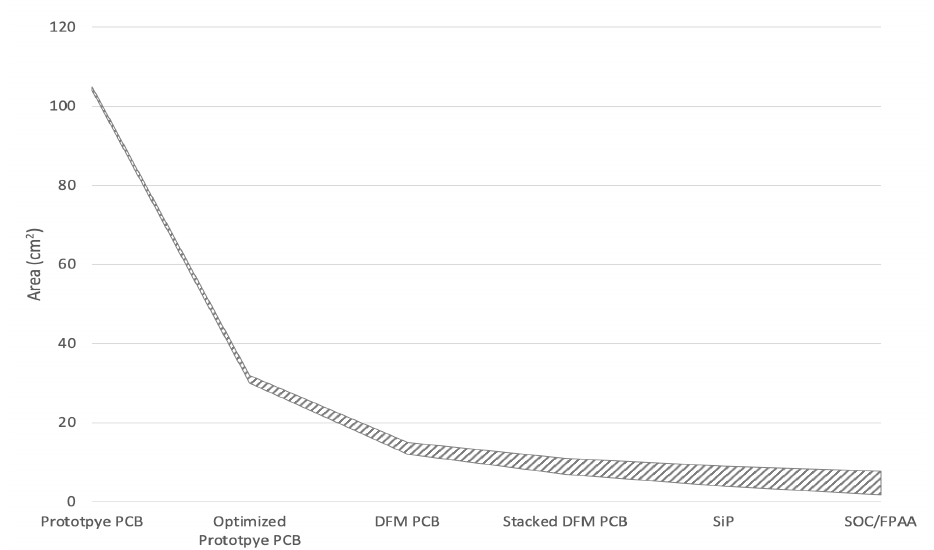
Figure 7. Board/Package Area Projection with Different Levels of Design Integration, starting from the current prototype with the PCB size of 104 cm 2 , followed by an optimised PCB with a 20% components density and a design for manufacturability (DFM) design with a 50% components density; further minimisation could be performed by a stacked PCB or SiP (system in package) design, or by the chip-level FPAA/SoC